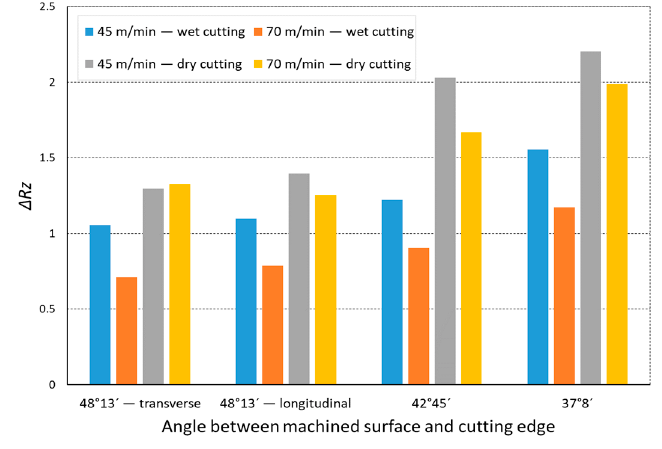
Figure 14. The impact of angle between the machined surface and cutting edge on ratio Δ Rz of the average measured surface roughness height to the theoretical surface roughness Rz to for a rectilinear track and 36 HRC.